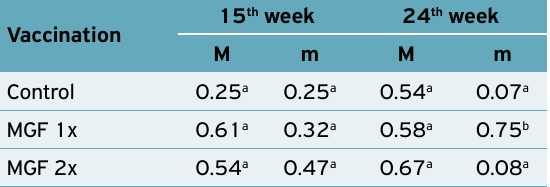
Table 1. Serological responses by enzyme-linked immunosorbent assay (ELISA) optical density (OD) for MG-F in unvaccinated chickens (G1) and vaccinated with one dose at 8 th (G2) and two doses at 8 th to 11 th week of age (G3) according to age in weeks.